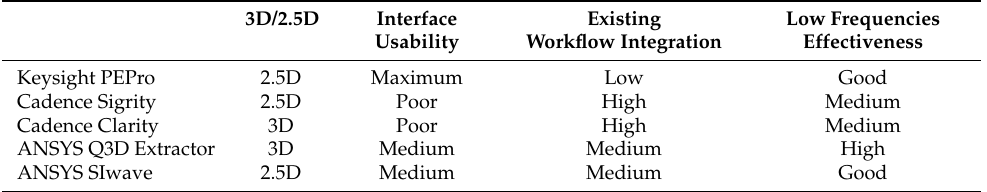
Table 4. Comparative analysis of software for 3D/2.5D electromagnetic